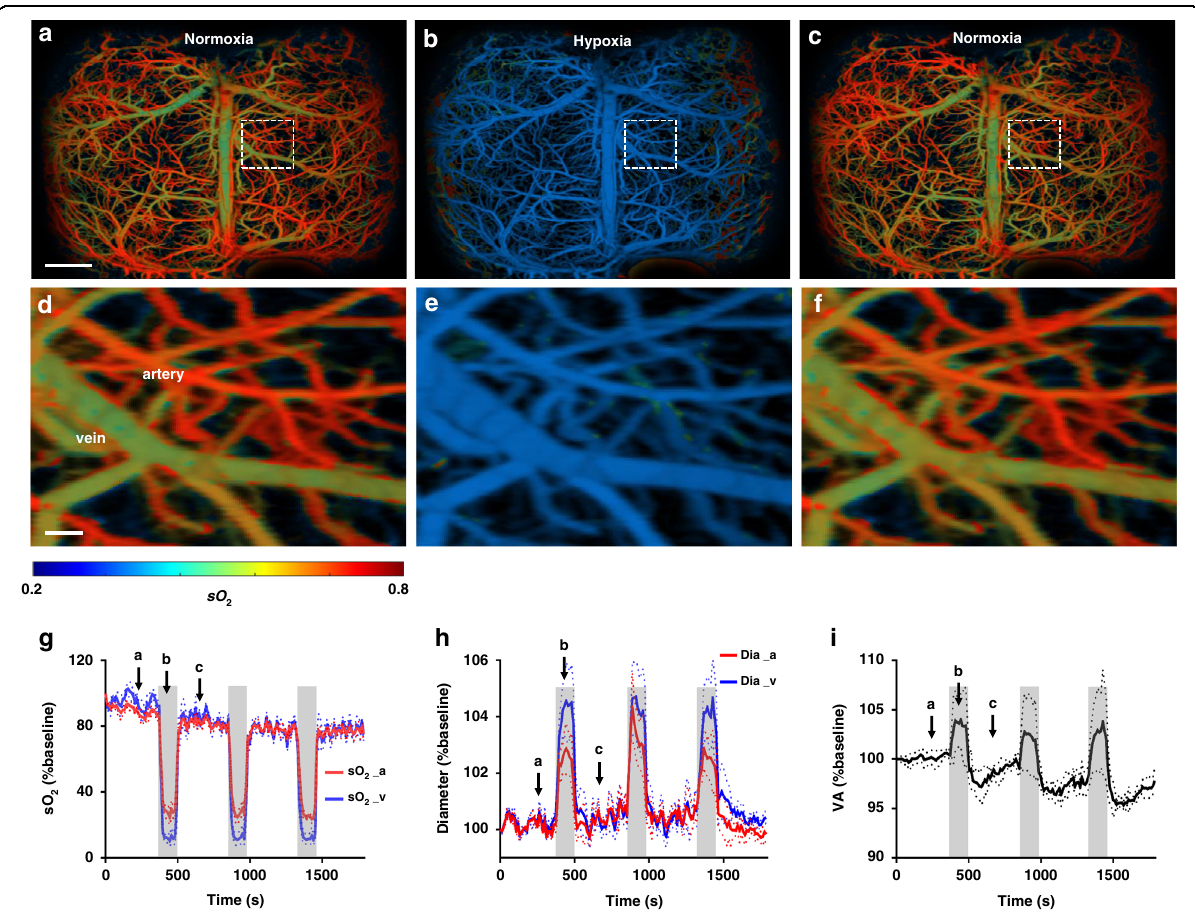
Fig. 3 UFF-PAM of brain hemodynamics under hypoxia. a – c sO 2 images of the entire mouse cortex under a cycle of normoxia, hypoxia, and then returned to normoxia. d – f Close-up images of the dashed box regions in ( a – c ). g The averaged sO 2 changes in arteries (sO 2 _a) and veins (sO 2 _v). The gray areas indicate the hypoxia challenges. The arrows represent the time points corresponding to ( a – c ). h The diameter changes of the marked artery and vein in ( d ). i Vessel area (VA) change of the whole cortex. N = 4. The data in ( g – i ) are shown as mean ± s.e.m. Scale bar, 1 mm in ( a – c ), 100 μ m in ( d – f